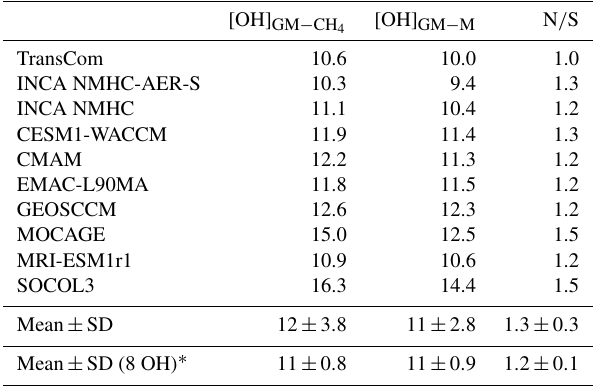
Table 1. Global tropospheric mean [OH] ( × 10 5 moleccm − 3 ) and interhemispheric OH ratios (N / S) averaged over 2000–2002 for 10 OH fields used in this study. The global tropospheric [OH] weighted by reaction with CH 4 ([OH] GM − CH dry air mass ([OH] GM − M ) are both